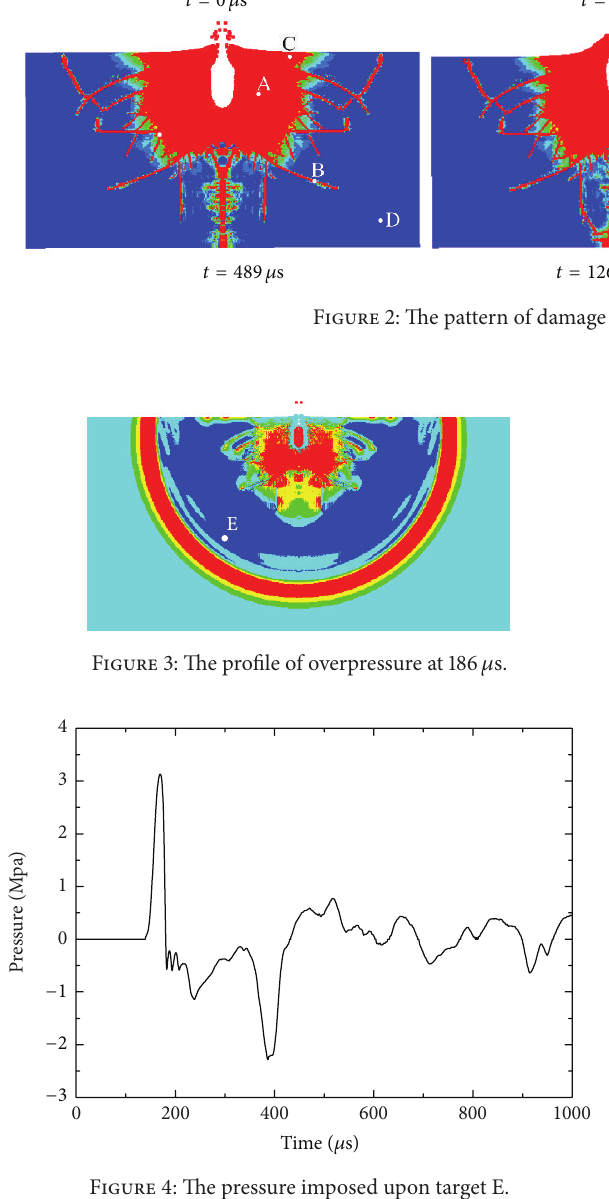
Figure 4: The pressure imposed upon target E.